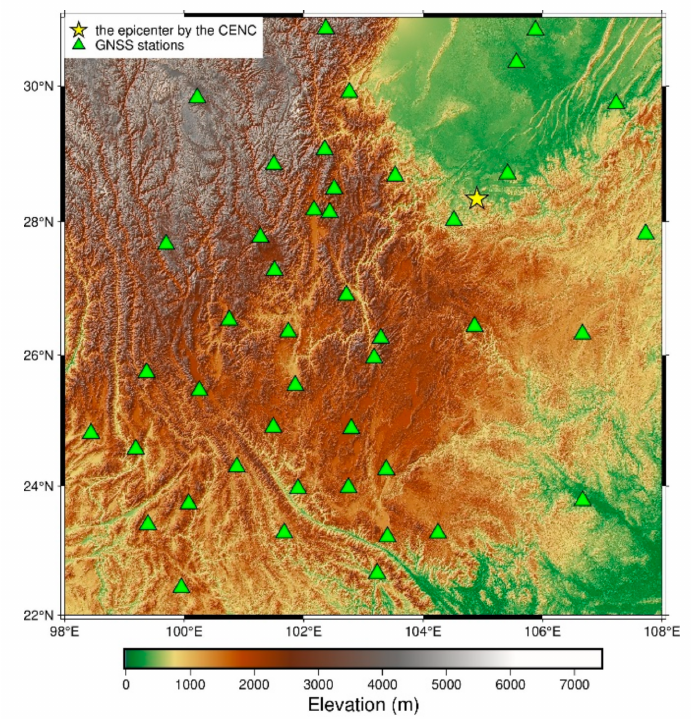
Figure 2. Distribution of selected GNSS stations in the crustal movement observation network of China near the area of interest. The green triangle represents the selected GNSS stations of the Crustal Movement Observation Network of China (CMONC). The yellow pentagram represents the location of the epicenter by the China earthquake networks center